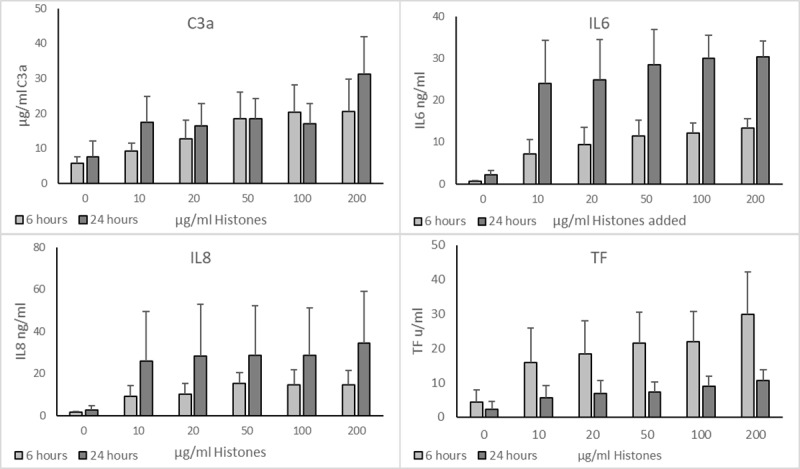
Effect of histones on inducing inflammatory markers in human whole blood over 6 and 24 hours.Whole blood was stimulated with increasing concentrations of histones over 6 and 24 hours. Released C3a, IL-6 and IL-8 were measured in plasma and tissue factor was measured from the cellular component. For each timepoint all concentrations were p < 0.001 relative to the background (0 μg/ml) reading by Dunnett’s multiple comparison. Error bars = standard deviation of the average from 6 donors.